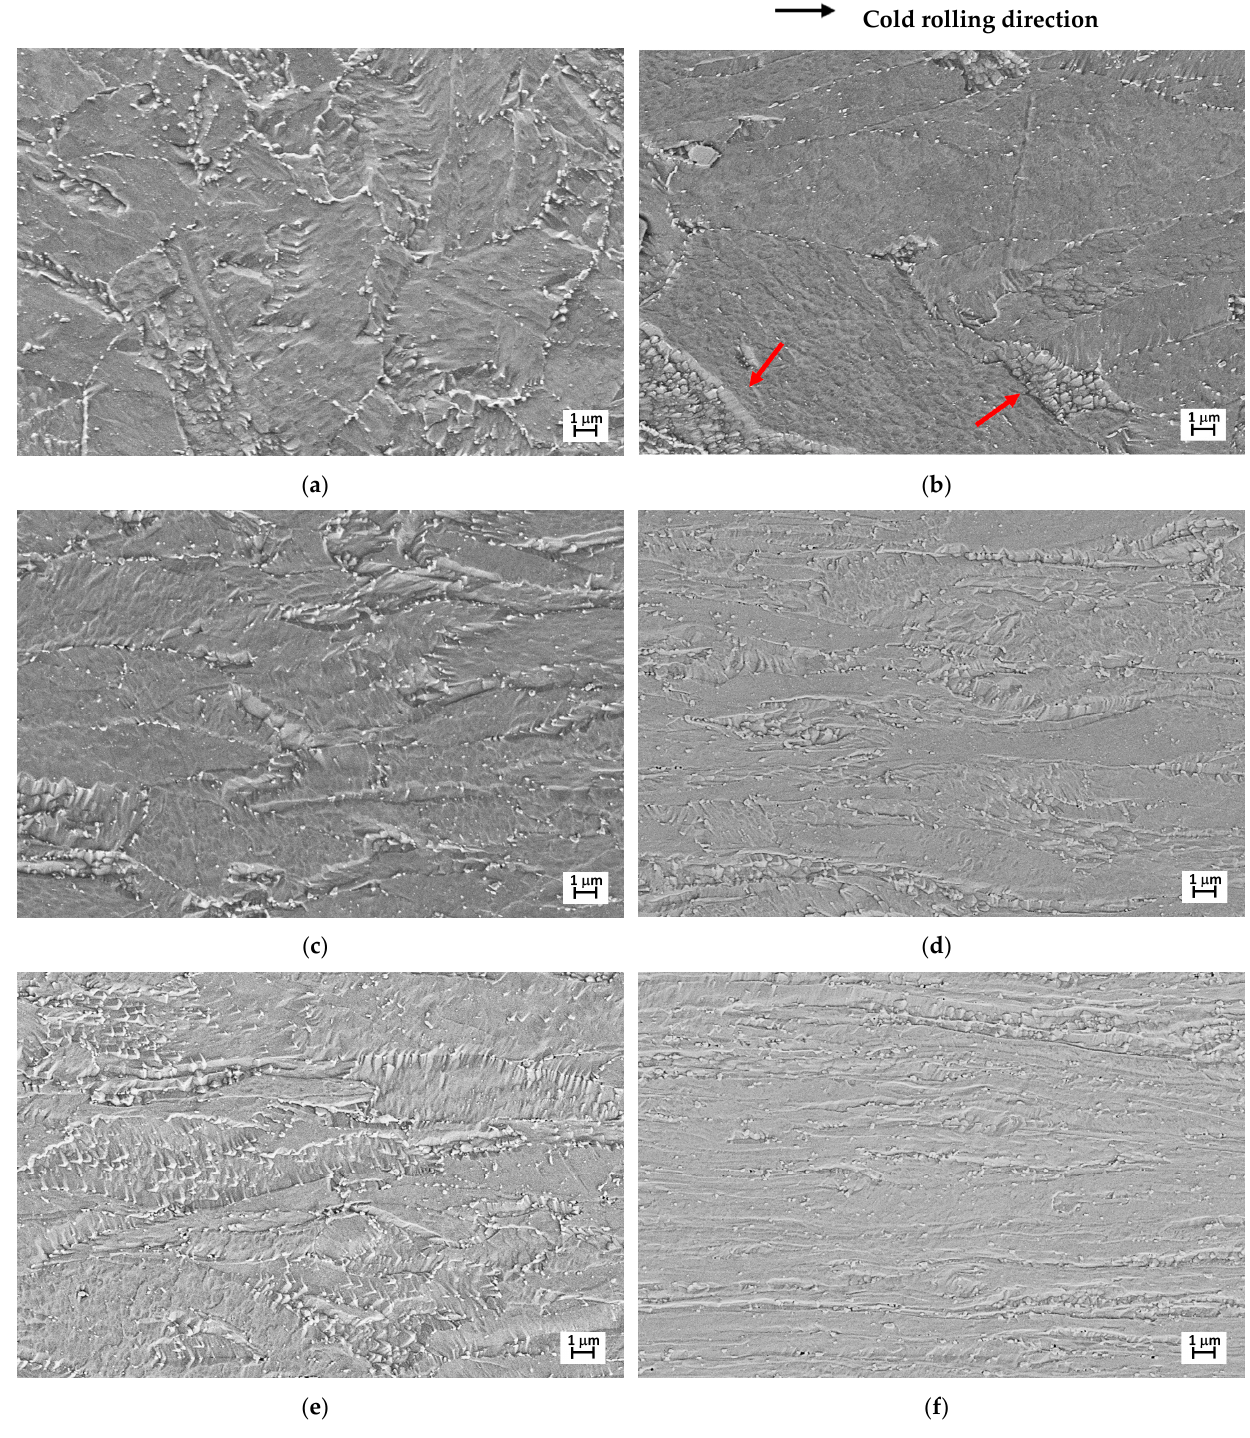
Figure 2. EUROFER97 steel. SEM micrographs of the material in standard condition ( a ) and after cold rolling with increasing CR ratio: 20% ( b ), 40% ( c ), 50% ( d ), 60% ( e ) and 80% ( f ).